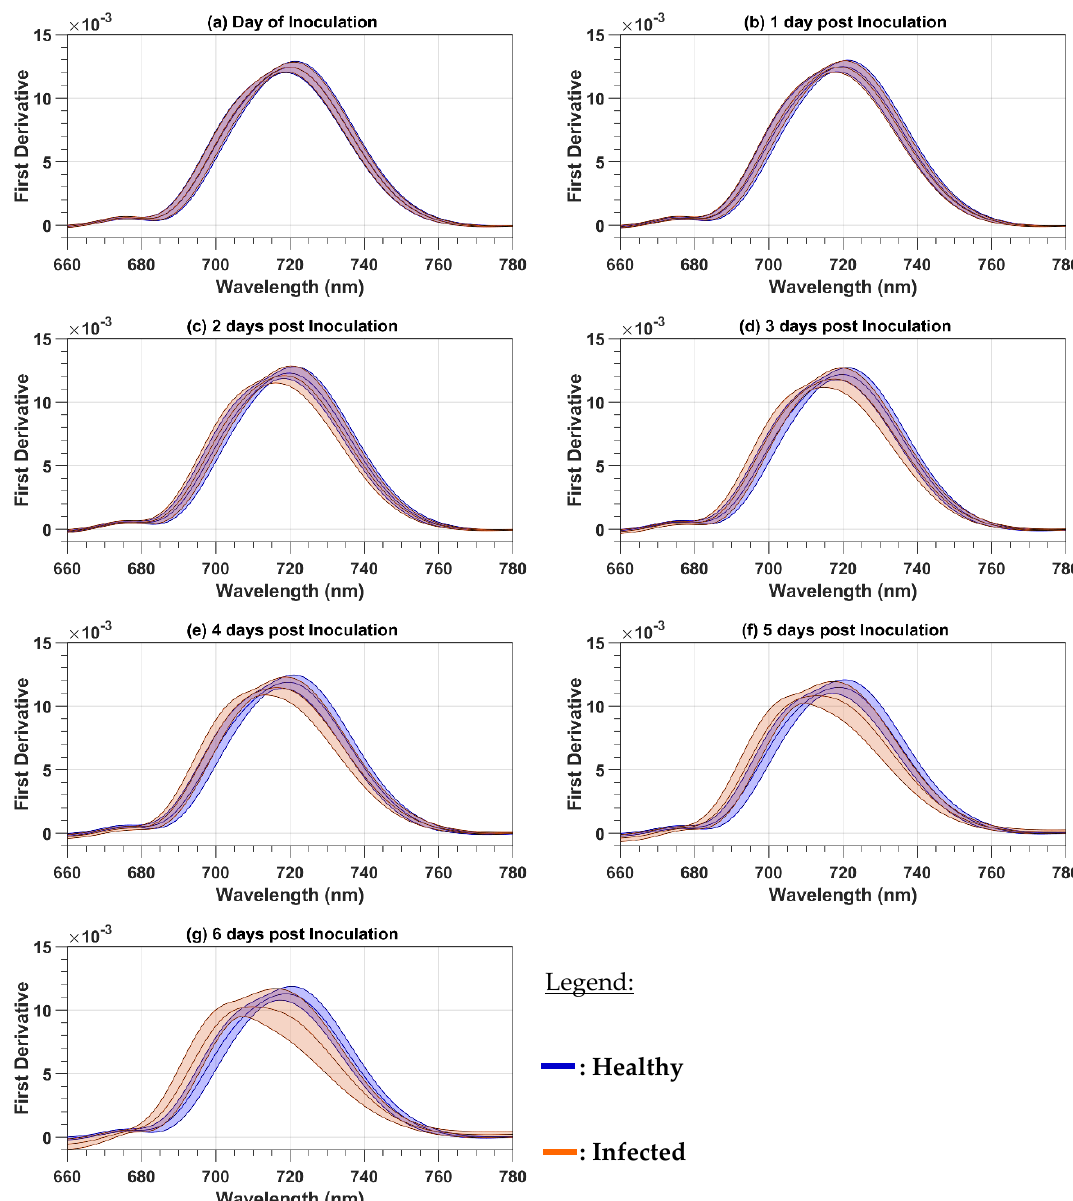
Figure 5. Comparison between healthy and infected leaves for the mean first-order derivative reflectance spectra (with one standard deviation) in the red region (660 to 680 nm) and red-edge region (680 to 780 nm) a function of the number of days post-inoculation ( a – g ).